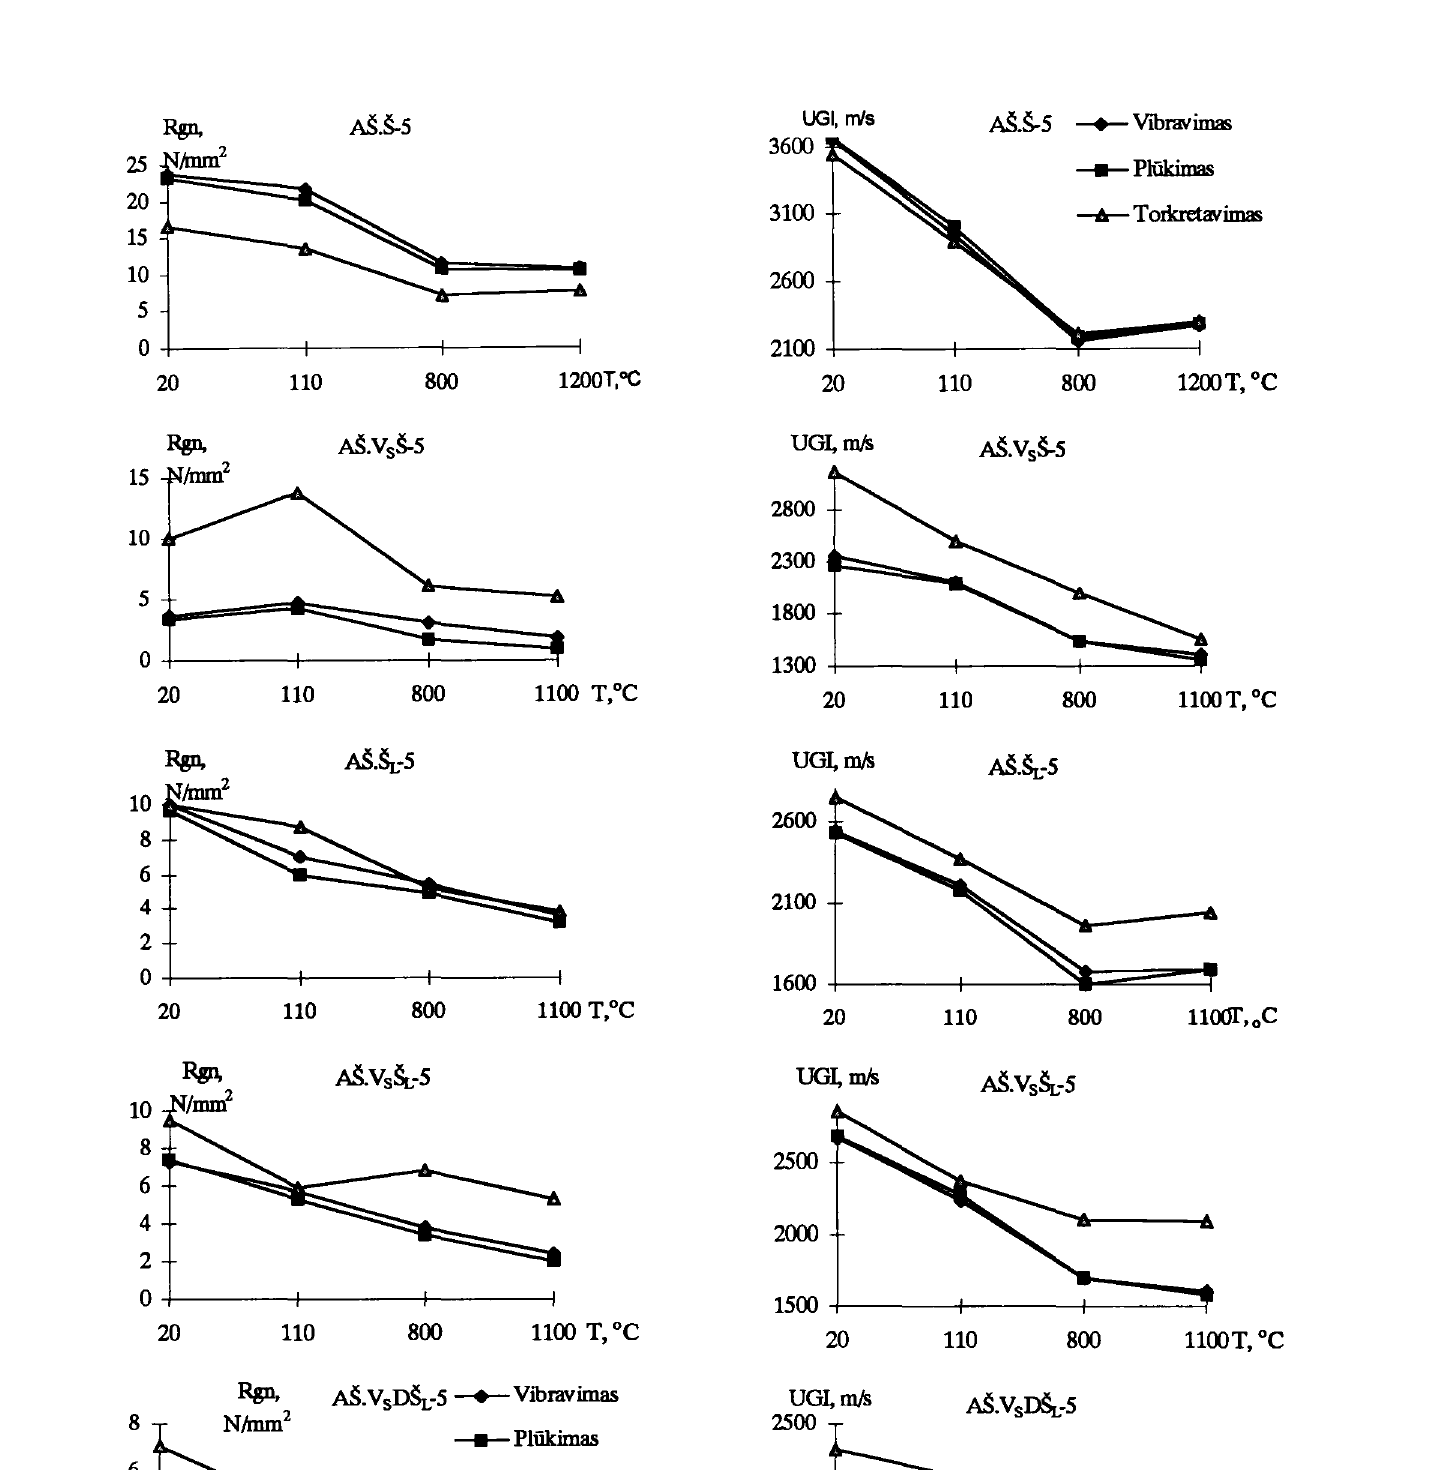
Fig. 3. Cold crushing strength dependence on firing Fig. 4. Ultrasonic impulse velocity dependence